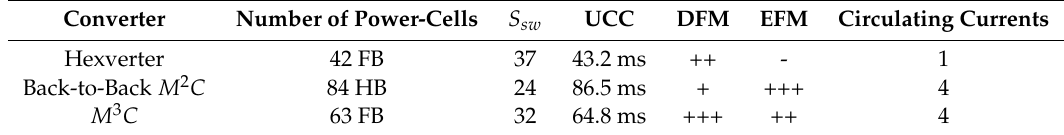
Table 2. Preliminary comparison of AC-to-AC MMCs. Source